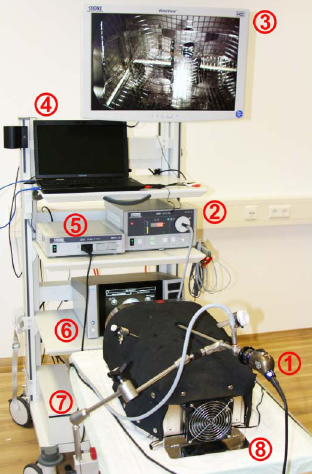
Figure 2. Experiment setup at the surgical training center in Tübingen with (1) endocam with attached laparoscope, (2) light source, (3) LCD monitor, (4) computer for media recording and processing, (5) camera control unit, (6) electrosurgical control unit, (7) mechanical support arm, (8) box trainer including ventilation system.